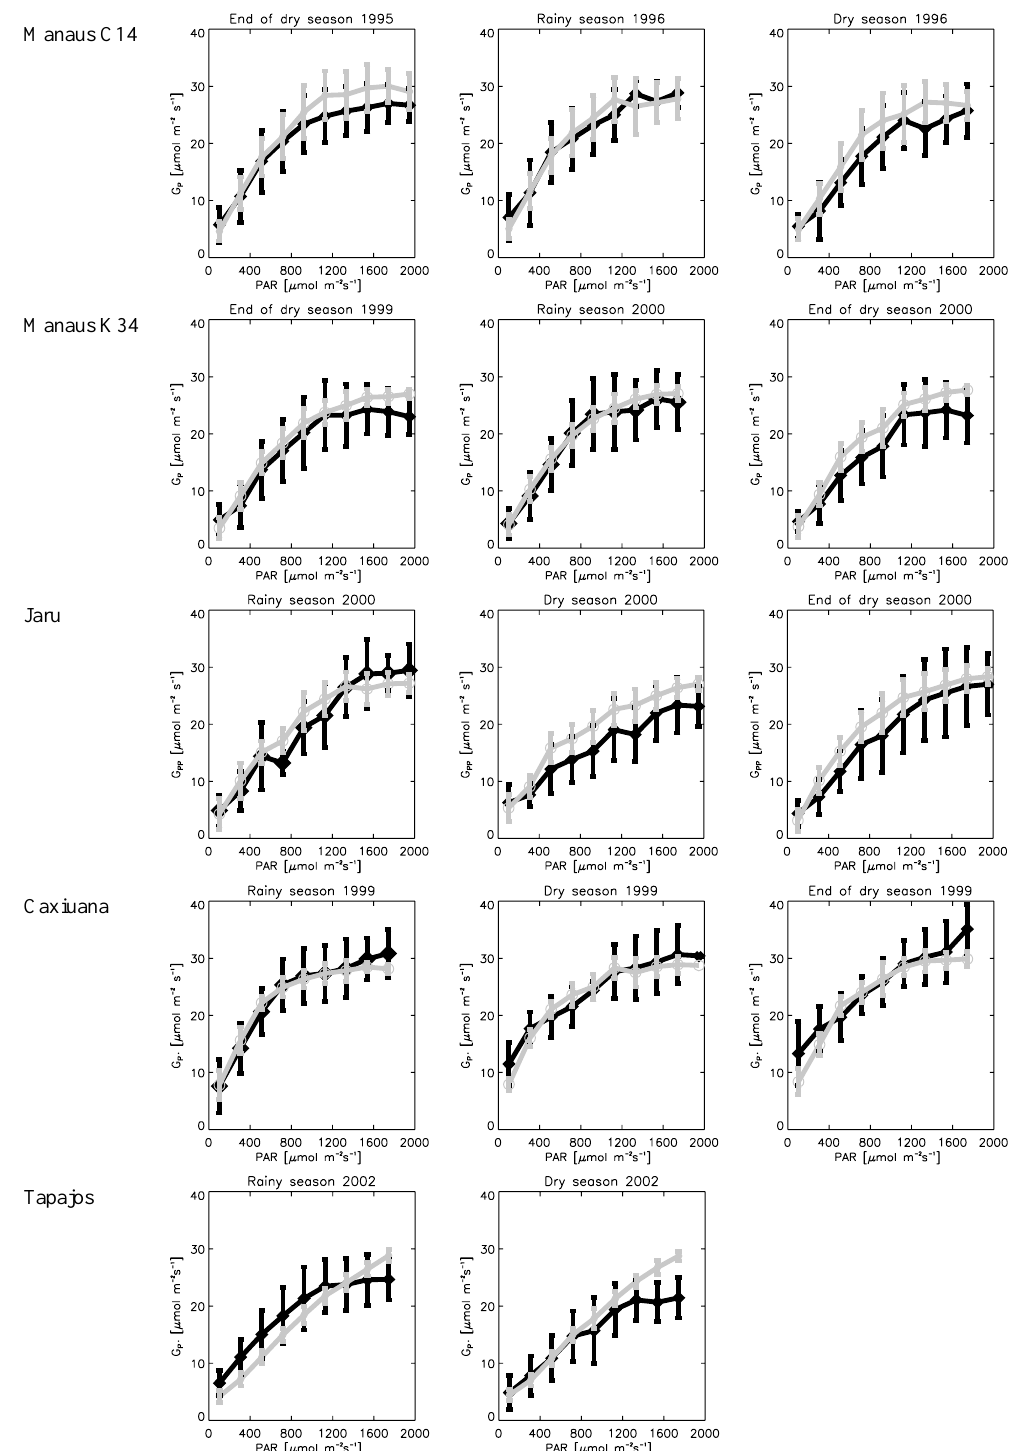
Fig. 2. Light response of observed (black) and simulated (grey) values of G P during the seasons